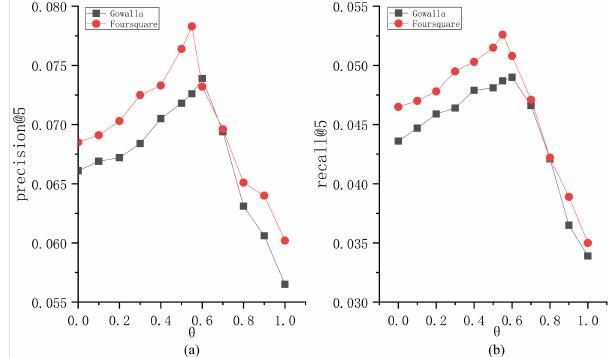
Figure 3. The sensitivity analysis of θ . ( a ) precision @5; ( b ) recall @5.